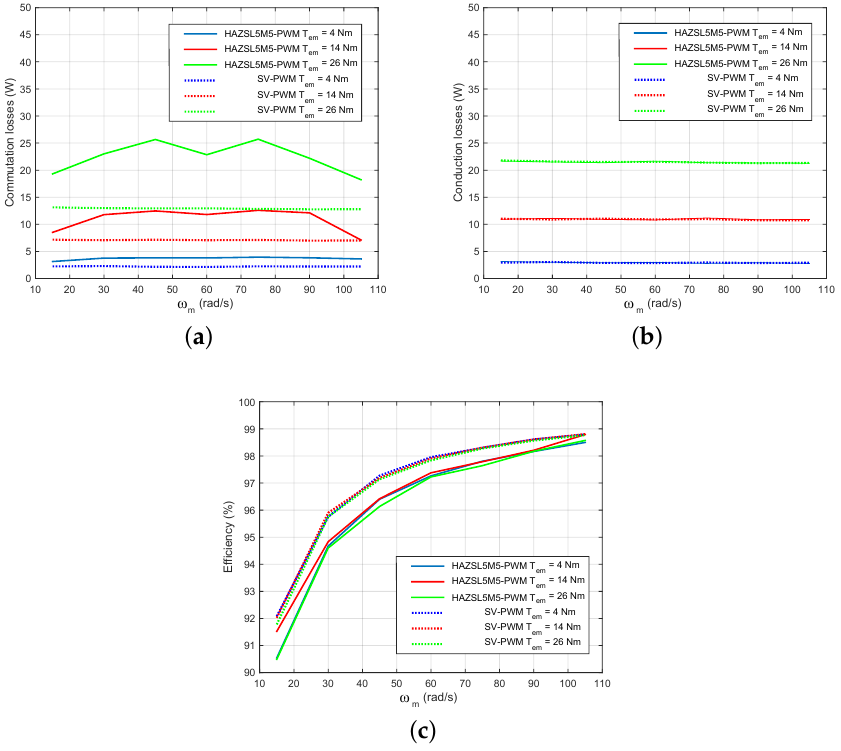
Figure 13. Power losses and efficiency of the proposed HAZSL5M5-PWM algorithm compared to other modulation techniques. ( a ) EMA switching losses for the studied modulation techniques. ( b ) EMA conduction losses for the studied modulation techniques. ( c ) EMA system efficiency with for the studied modulation